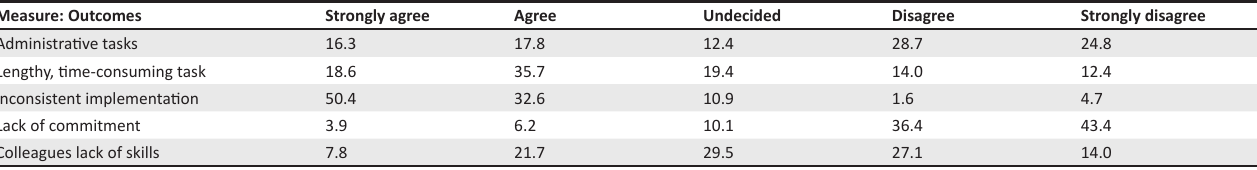
TABLE 4: Longer-term perceived outcomes of the performance management system (line managers). Measure: Outcomes